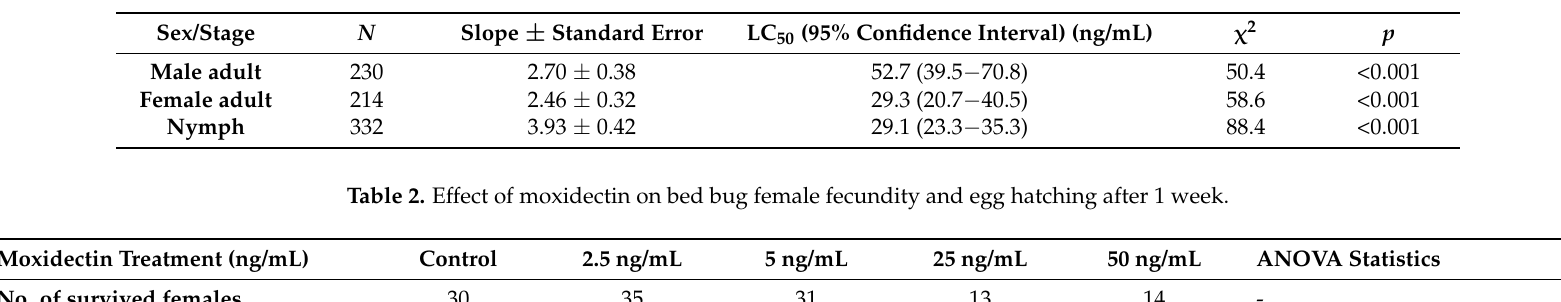
Table 1. Probit analysis results of toxicity of moxidectin against bed bugs.